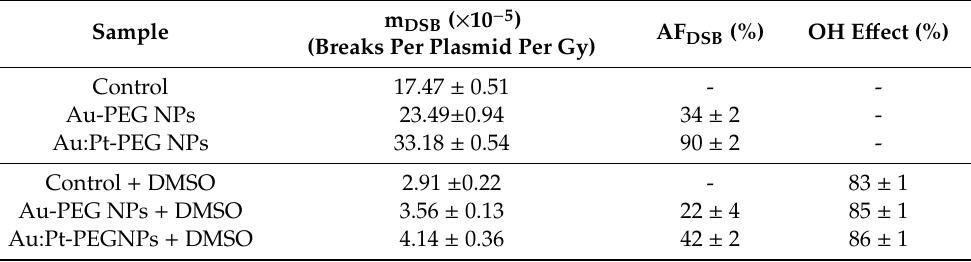
Table 2. Yields of nanosize biodamage (m DSB ) induced by radiation in the control and NP-loaded samples. Amplification factors (AFs) of mono- and bimetallic NPs and the contribution of water-mediated e ff ect (OH e ff